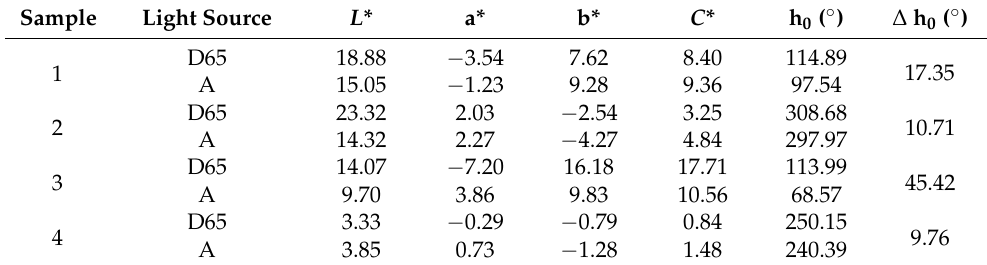
Table 4. Colour parameters of each sample in CIE Lab